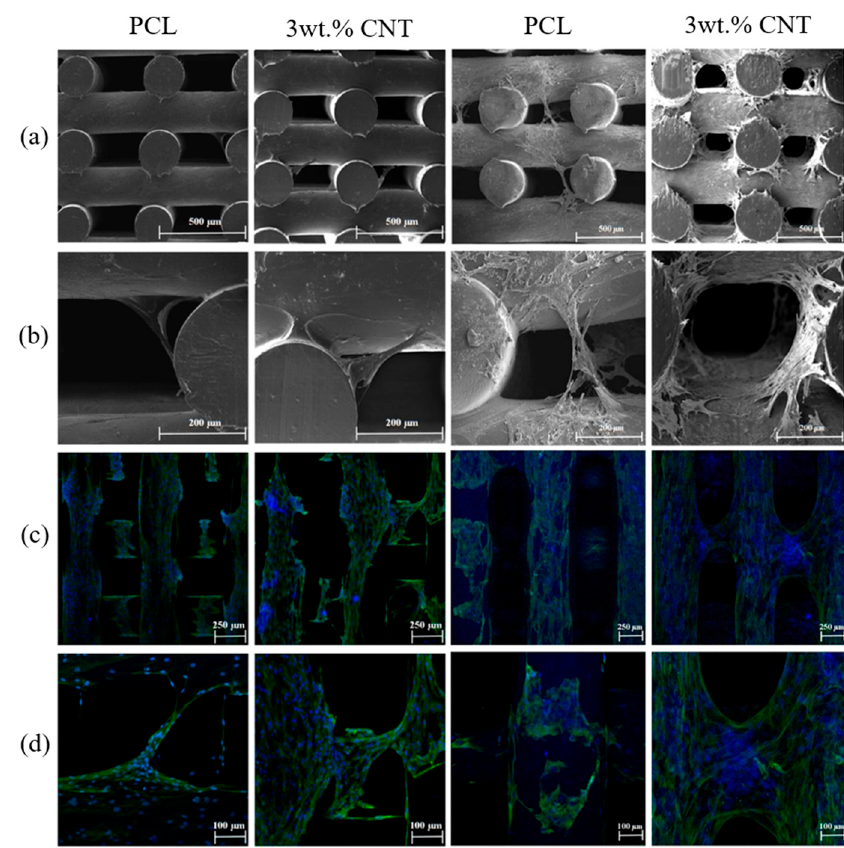
Figure 17. ( a , b ) SEM images at 65× and 230× magnification, ( c , d ) confocal microscopy images at 100 × and 200 × magnification of PCL and 3 wt.% PCL/CNT cell-seeded scaffolds, 7 days (left 2 columns)